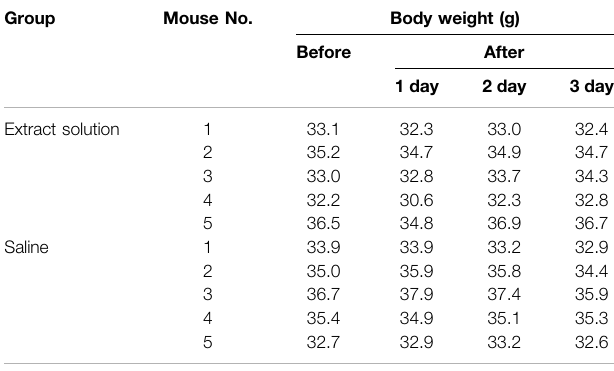
TABLE4| Bodyweightsofthemicebeforeandafterintravenousinjectionwiththe Fe 3 O 4 @Agar/HA extract solution or saline. Group Mouse No.